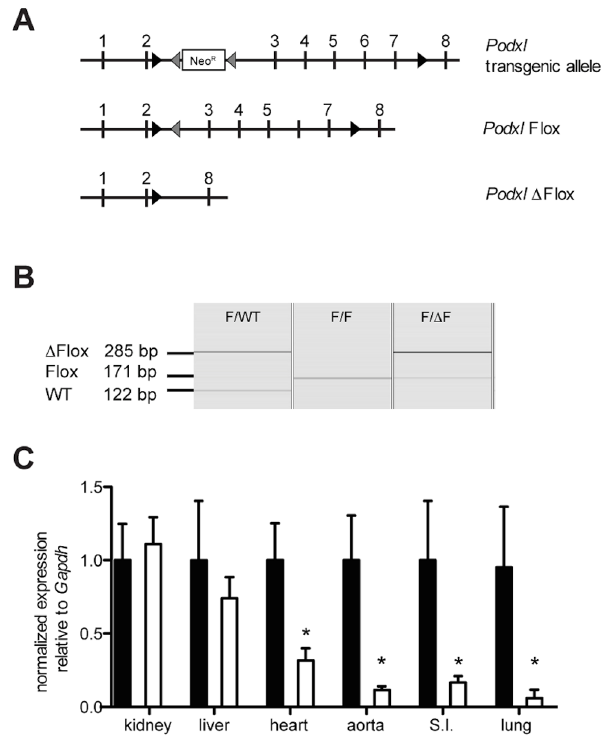
Figure 1. Conditional deletion of the Podxl locus in endothelial cells. ( A ) Schematic representation of the Podxl transgenic allele, floxed allele (Podxl F/F ) and deleted allele ( Podxl D F/F ). Exons are depicted as vertical lines. Inserted loxP and frt sites are depicted with black and grey arrowheads, respectively. The Neo R cassette is represented by a box. ( B ) Capillary gel electrophoresis of genomic DNA isolated and amplified (PCR) from primary lung endothelial cells prepared from mice harboring wild type (WT, 122 bp), floxed (Flox, 171 bp) or functionally deleted (via Cdh5 -Cre) Podxl alleles ( D Flox, 285 bp) ( C ) qRT-PCR evaluation of podocalyxin mRNA in highly vascularized adult tissues harvested from Podxl F/F (black bars) and Podxl D EC (white bars) mice (n=3–6). Expression levels were quantified relative to Gapdh and then normalized to the mean Podxl expression in the Podxl F/F tissues. *Significantly different compared to Podxl F/F mouse tissue where P , 0.05 by Student’s t test. Error bars represent the SEM.